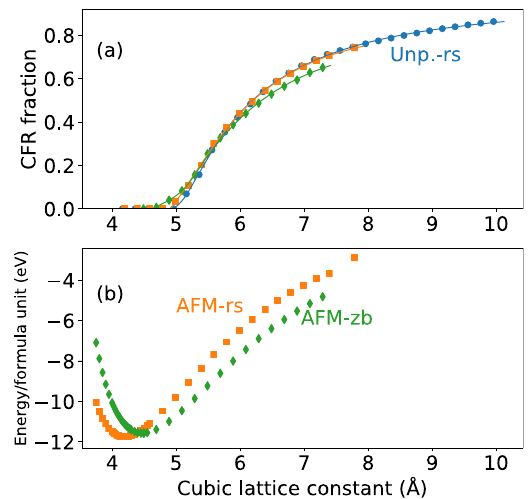
Fig. 6 Competing crystalline phases in Al and their CFRs. a CFR evolution for different spin-unpolarized cubic crystalline phases of Al, as calculated with PBE in VASP. b The fcc and ds phases become degenerate near a = 5.36 Å The fcc, bcc, and sc phases become nearly degenerate in energy as a grows large. Note that absolute energies do not have physical meaning in a pseudopotential calculation, only differences in energies. The fcc, bcc and sc phases were taken to contain one formula unit in the computational cell, and the ds phase to contain two formula units in the computational cell.